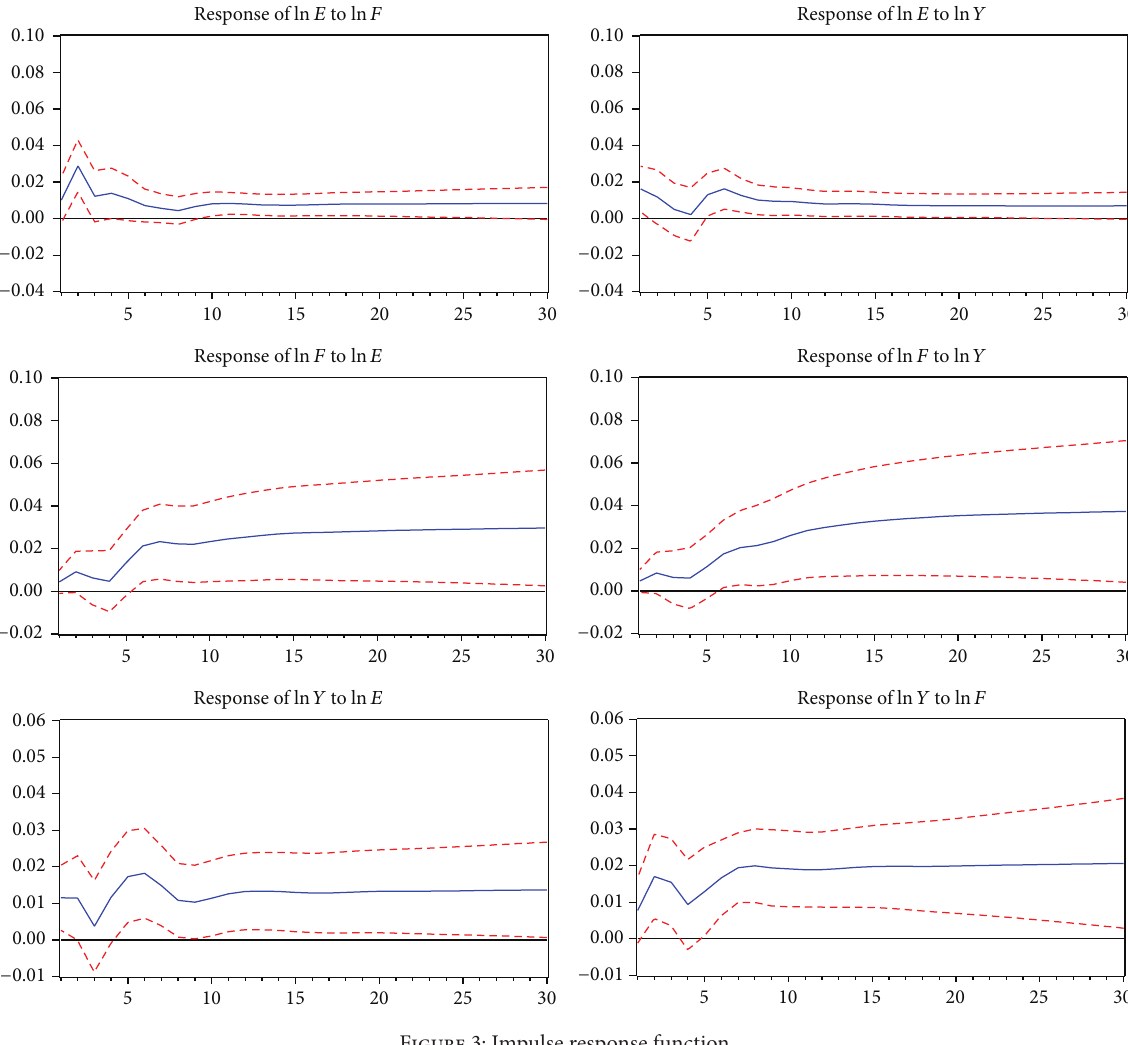
Figure 3: Impulse response function.